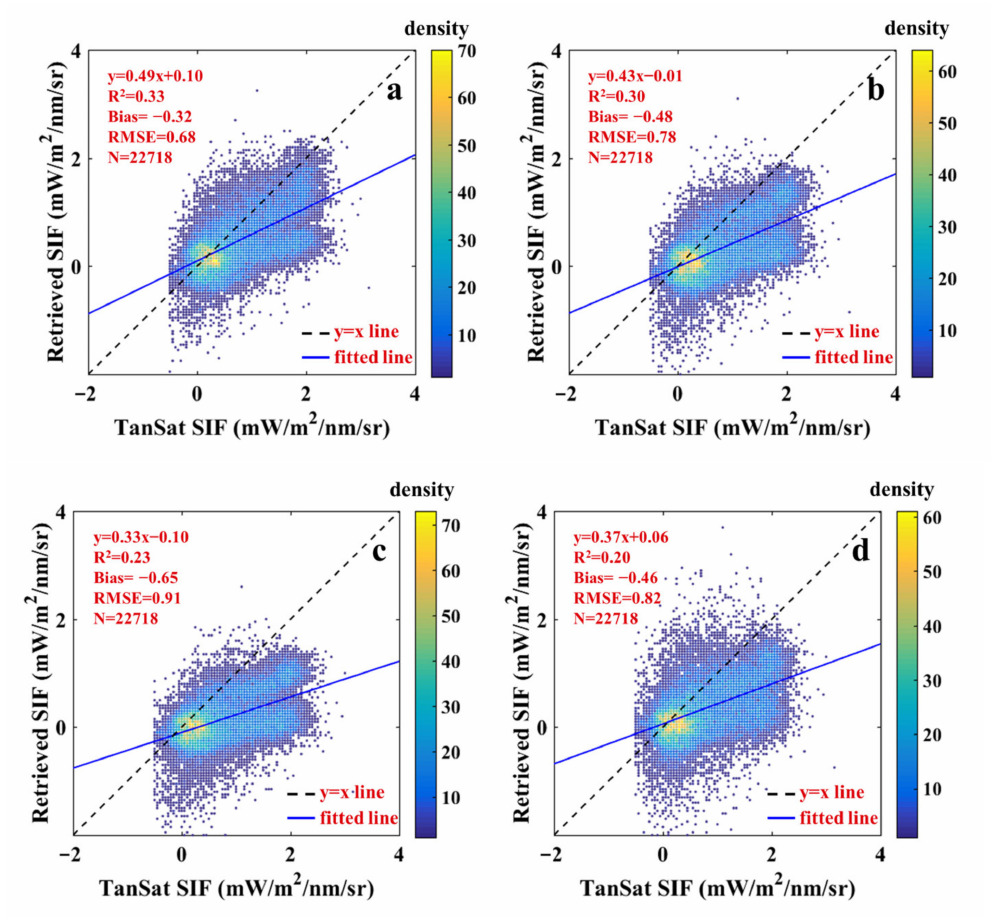
Figure 6. Scatter plot of SIF retrievals and TanSat SIF with different standard deviations: 20 ( a ), 25 ( b ), 35 ( c ), 40 ( d ). The color legend indicates the density of scattered points.